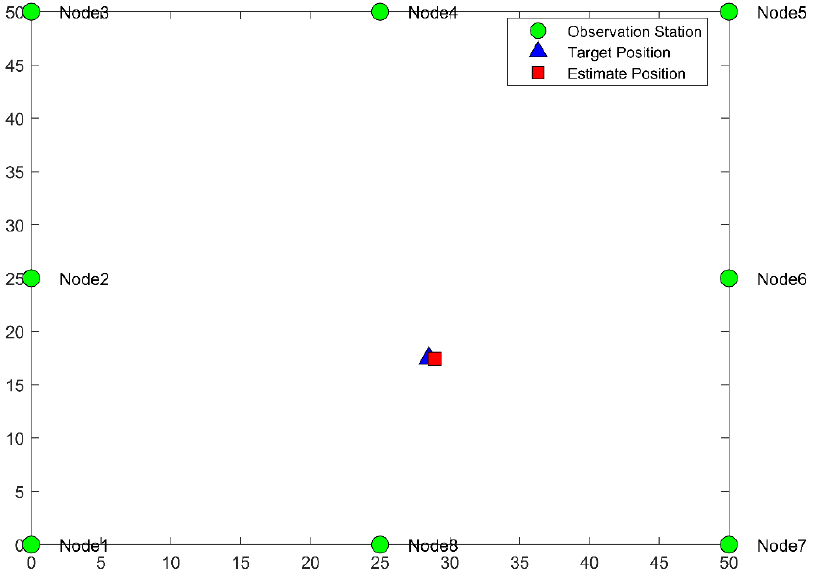
Figure 5. Positioning accuracy-test simulation diagram. Table 4. Localization accuracy comparison of different distance noise standard